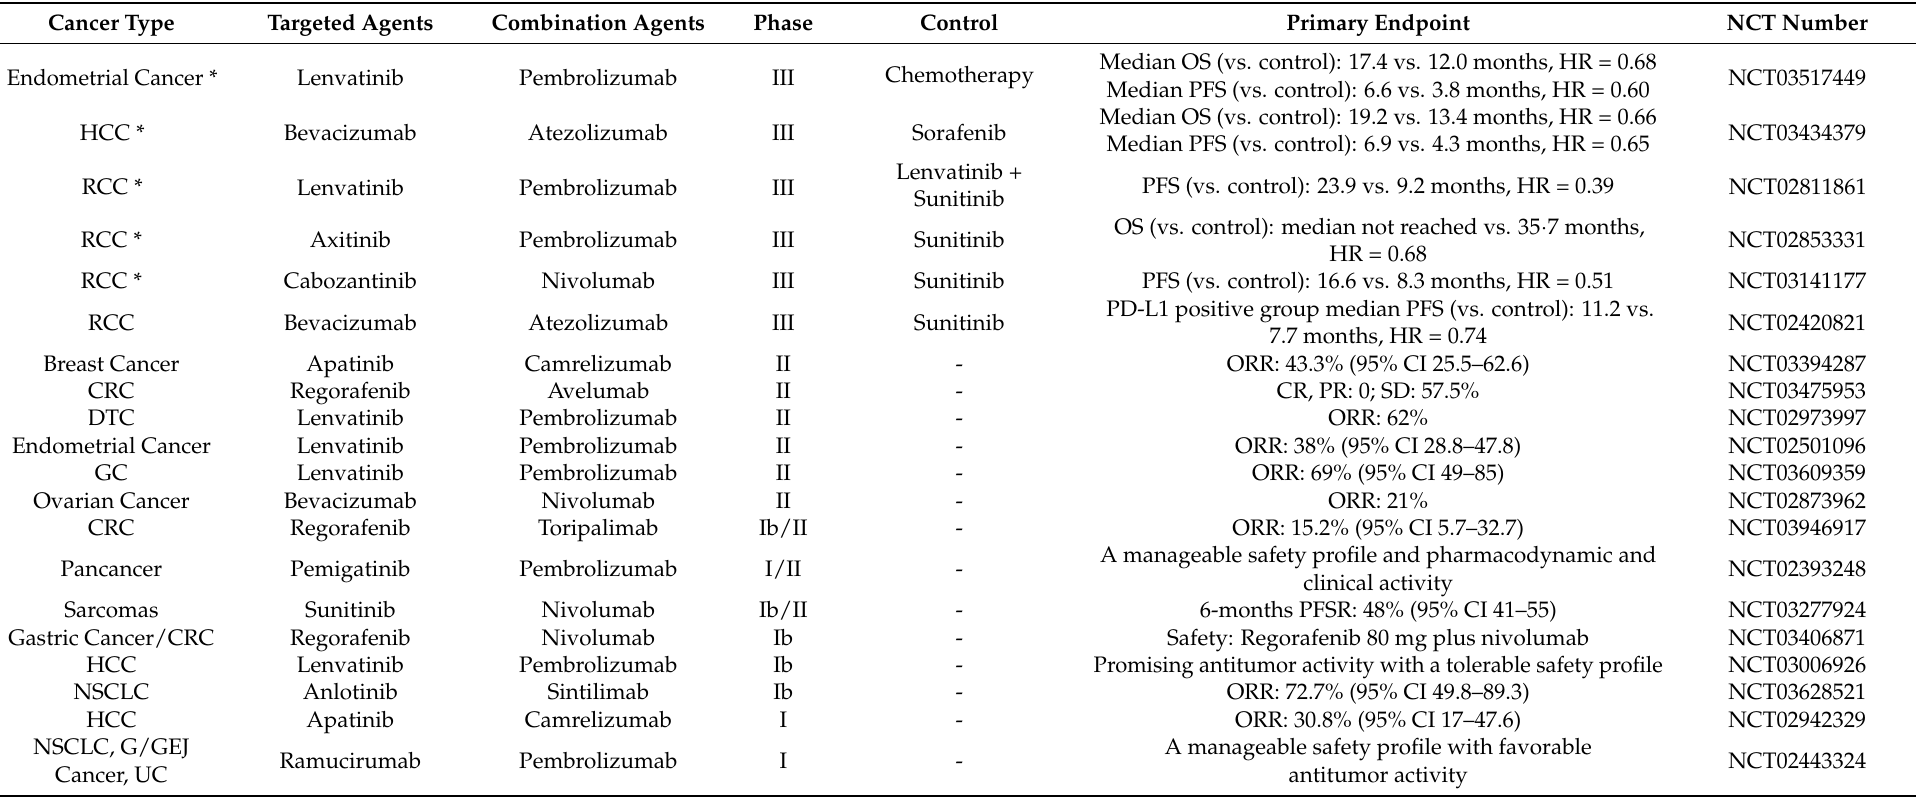
Table 2. Clinical trials of ICIs plus targeted agents targeting